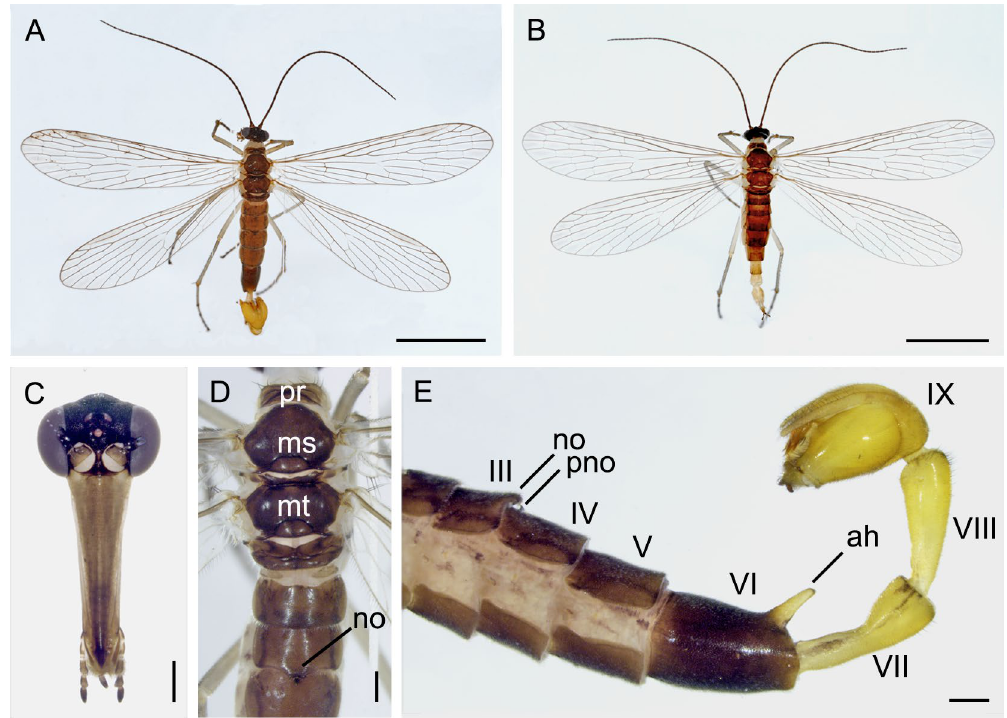
Fig. 11. Adults of Cerapanorpa yanggashana sp. nov. A . Male habitus in dorsal view. B . Female habitus in dorsal view. C . Male head with antennae removed in frontal view. D . Dorsum of male. E . Male abdomen in lateral view. Abbreviations: ah = anal horn; ms = mesonotum; mt = metanotum; no = notal organ; pno = postnotal organ; pr = pronotum. Scale bars: A–B = 5 mm; C–E = 0.5